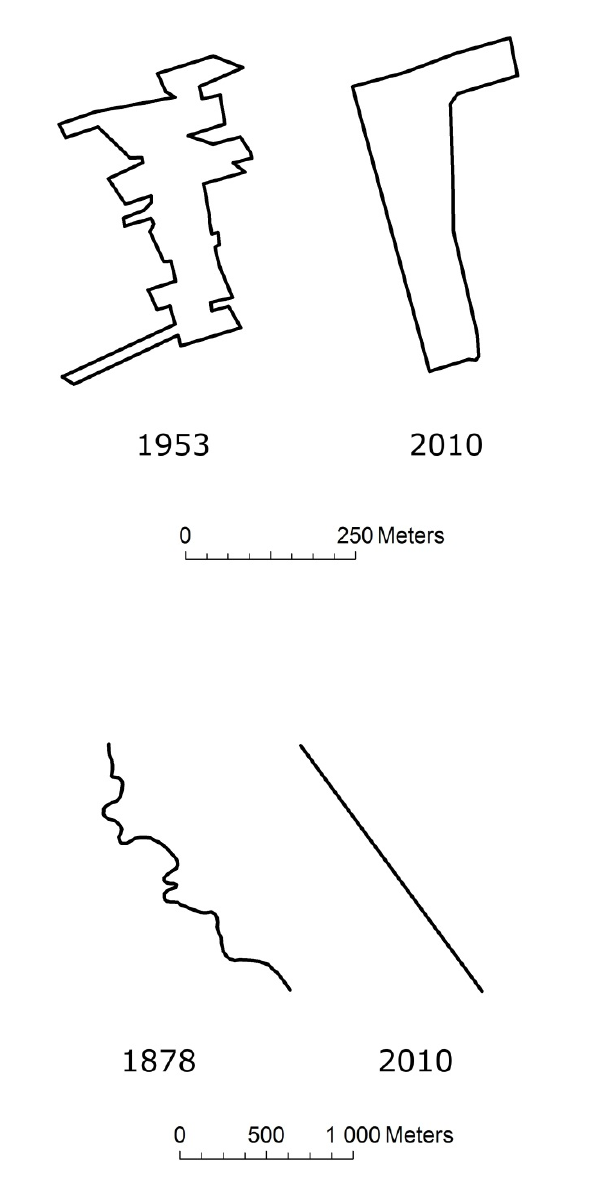
Figure 2. Straightened river